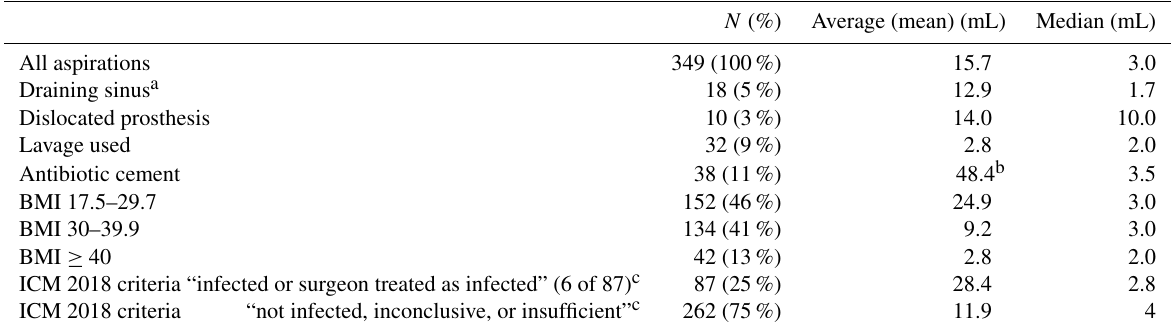
Table 2. Fluid aspiration average (mean) and median for various patient, arthroplasty, and fluid characteristics and infected vs. non-infected as per ICM 2018 criteria.